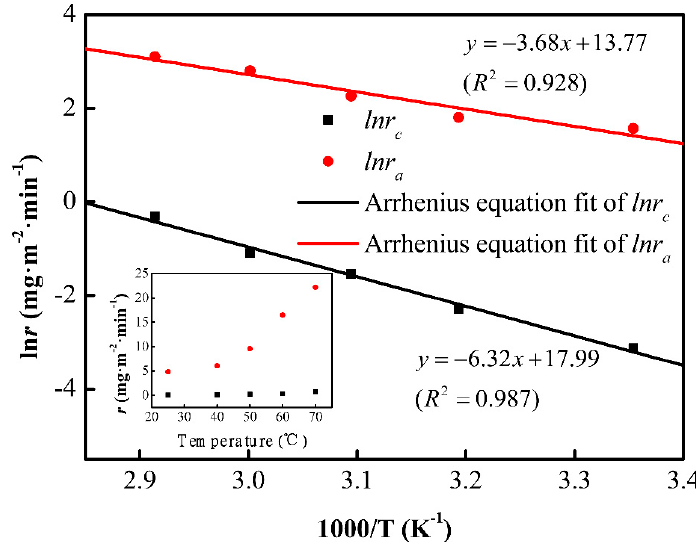
Figure 4. The etch rates of cordierite and amorphous phase fitted by the Arrhenius equation. Inset: The etch rates evolution depending on temperature.